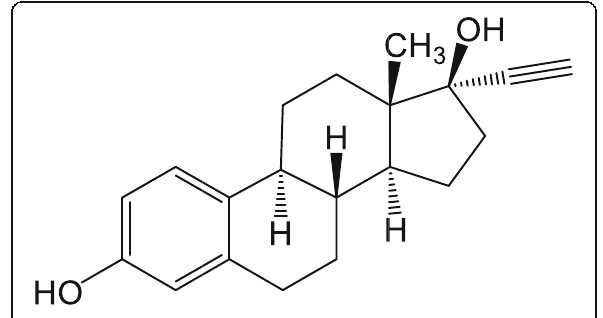
Fig. 1 Chemical structure of